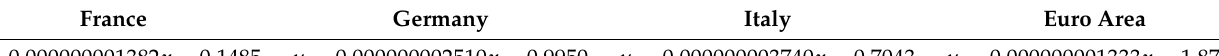
Table 1. Regression models of stage 1 (source: own work).